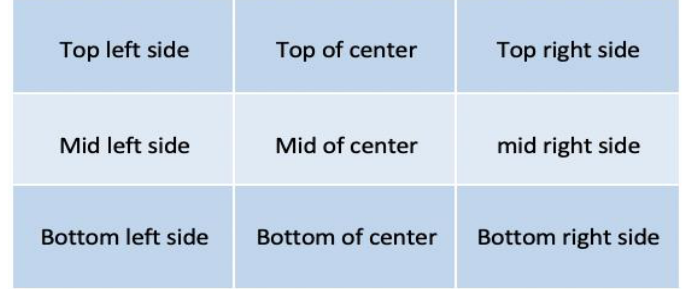
Figure 3. Map of the possible detected objects’ positions regarding the image.